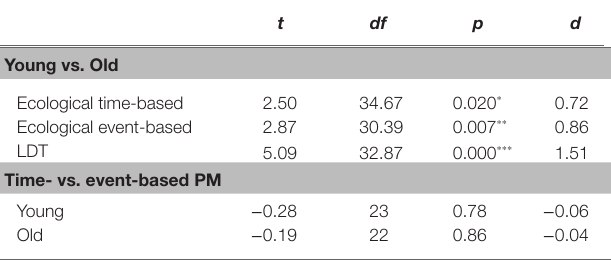
TABLE 4 | Planned comparisons on the PM Task accuracy.